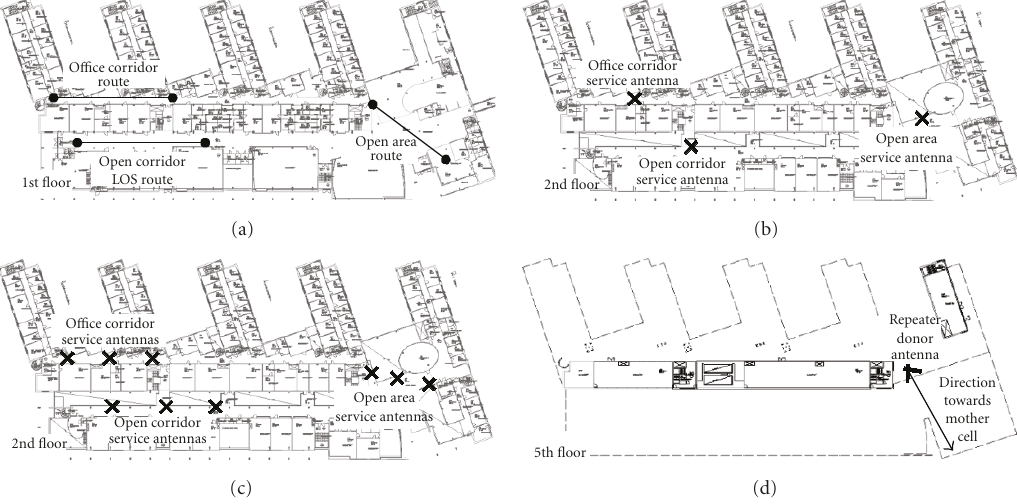
Figure 5: (a) Measurement routes for all indoor and repeater measurements, (b) antenna locations for 1 antenna, (c) 3 antennas, (d) and repeater donor